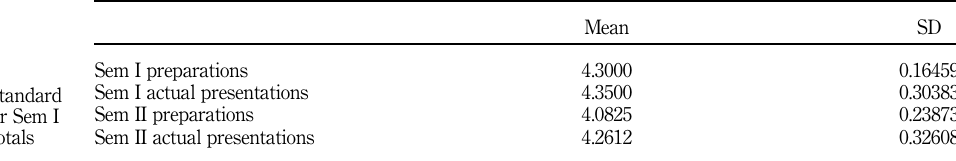
Table I. Means and standard deviations for Sem I and Sem II